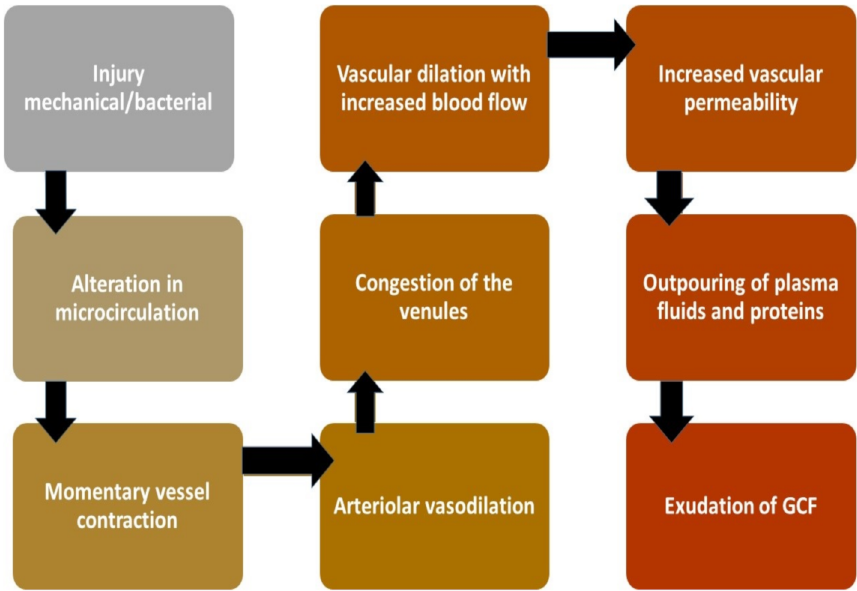
Figure 2. Mechanism of GCF production on stimulus